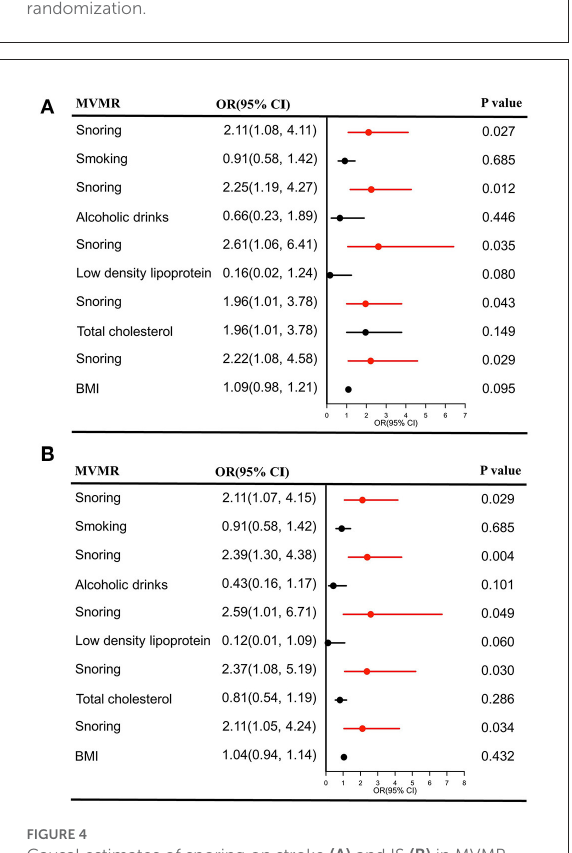
FIGURE3 Causal estimates of snoring on IS in SVMR. OR, odds ratio; CI, confidence interval; IVW, inverse variance weighted method; IS, ischemic stroke; RAPS, robust adjusted profile score; MR, Mendelian randomization; SVMR, single-variable Mendelian randomization.